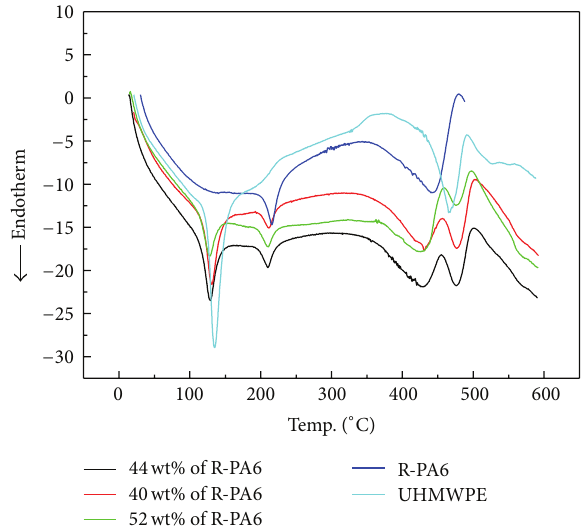
Figure 3: DSC curves of UHMWPE/R-PA6/HDPE-g-MAH with different amounts of R-PA6 and neat